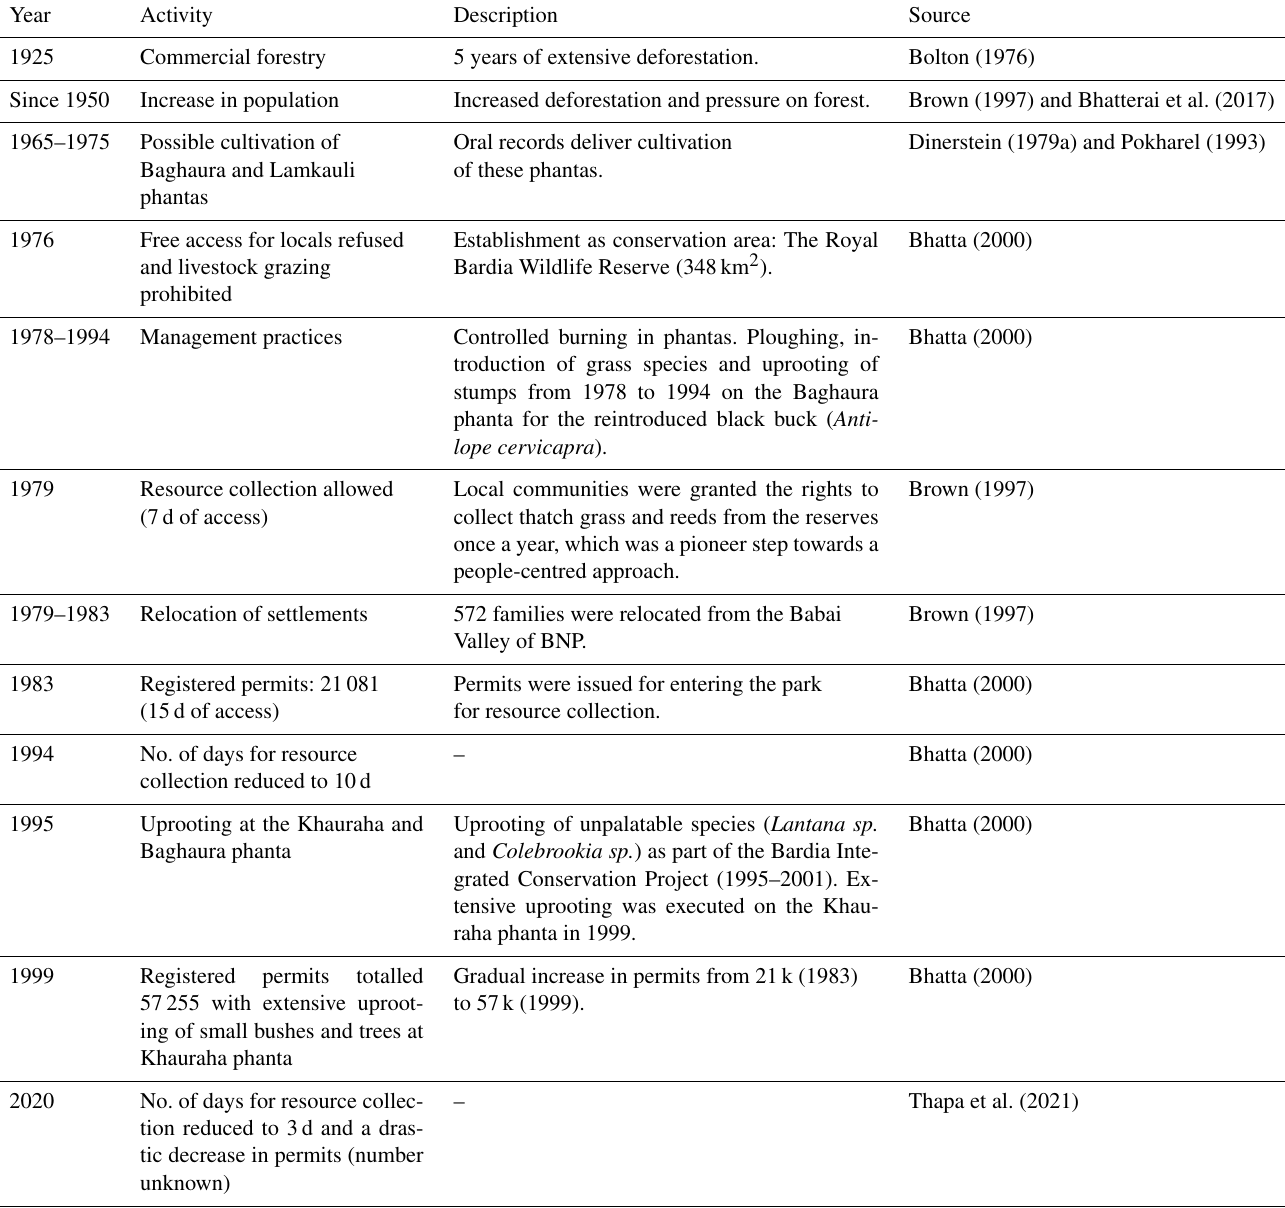
Table A1. Overview of anthropogenic activities in BNP as recorded in the